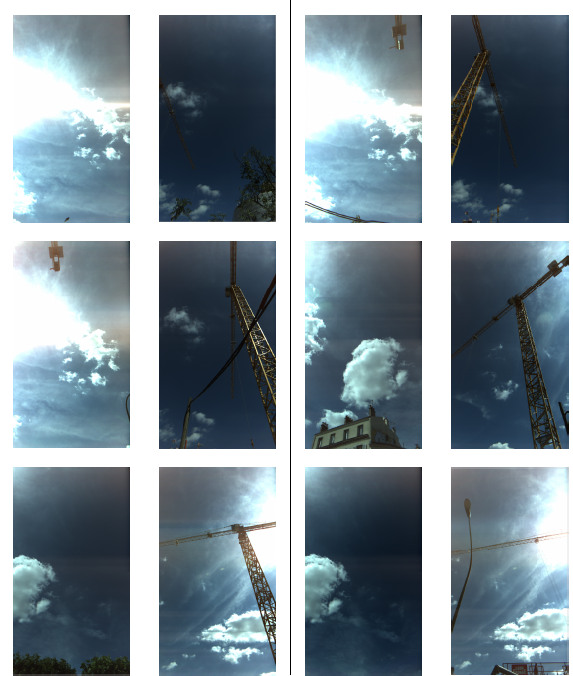
Figure 4: Images used for the radiance retrieval, from left and right cameras, for 6 vehicle locations (all images displayed with the same settings).